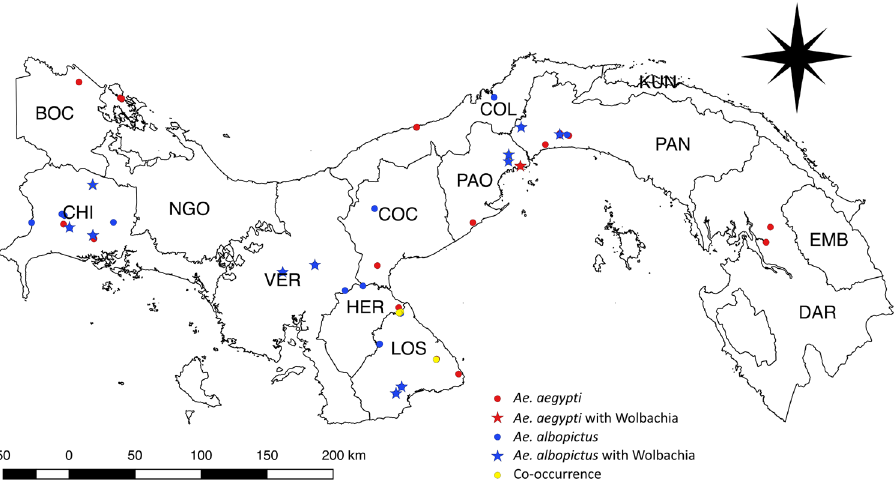
Figure 1. Sampling locations of Aedes mosquitoes across provinces and indigenous territories (also known as “ Comarcas ”) of Panama, including those confirmed to be infected with Wolbachia : Bocas del Toro (BOC),